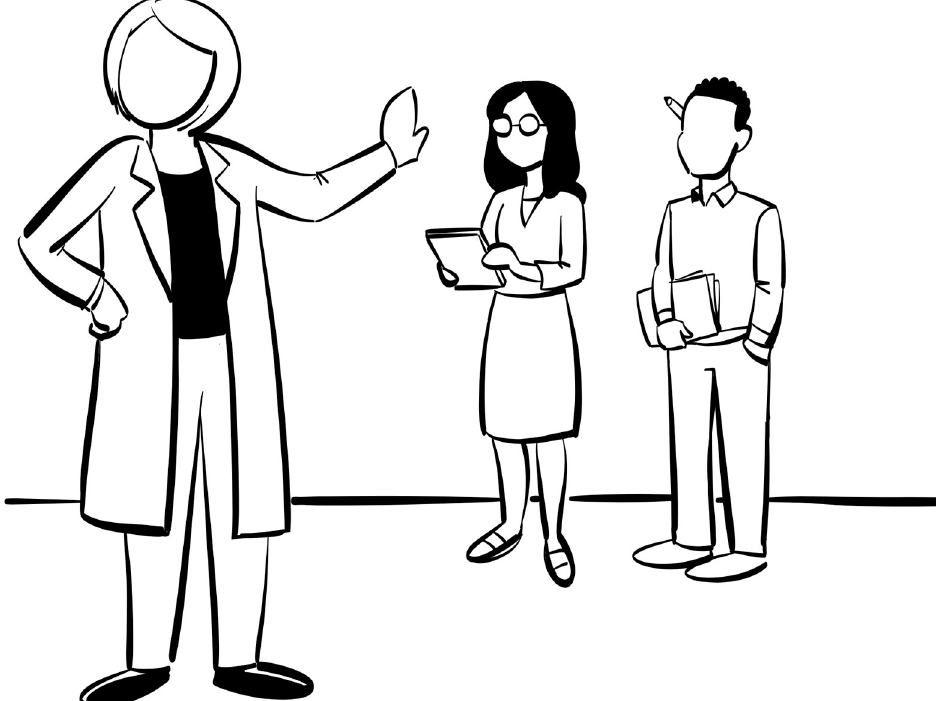
Fig 9. Who are these weirdos and why are they